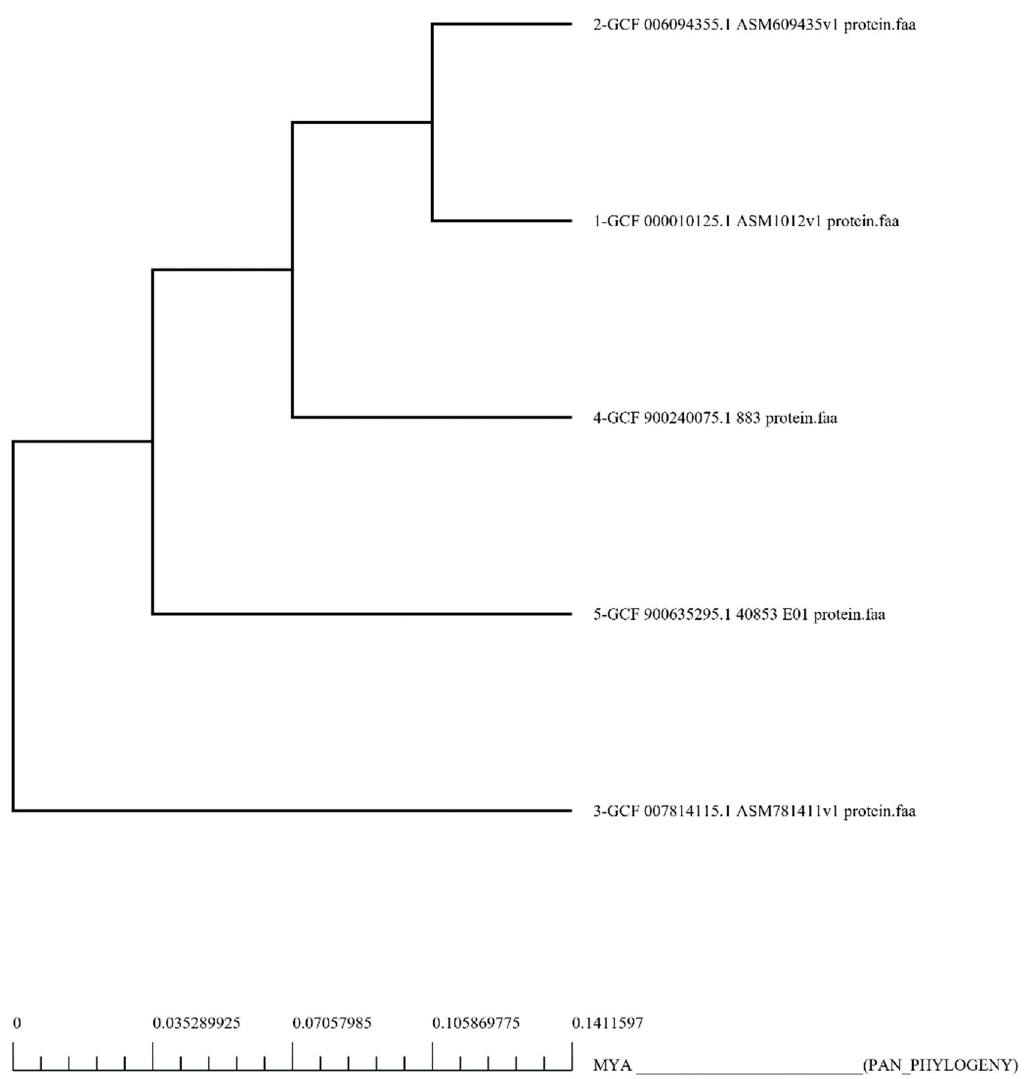
Figure 2. Core genomic phylogenetic tree of S. saprophyticus . The multiplex alignment of proteins associated with the core genome was used to create this core